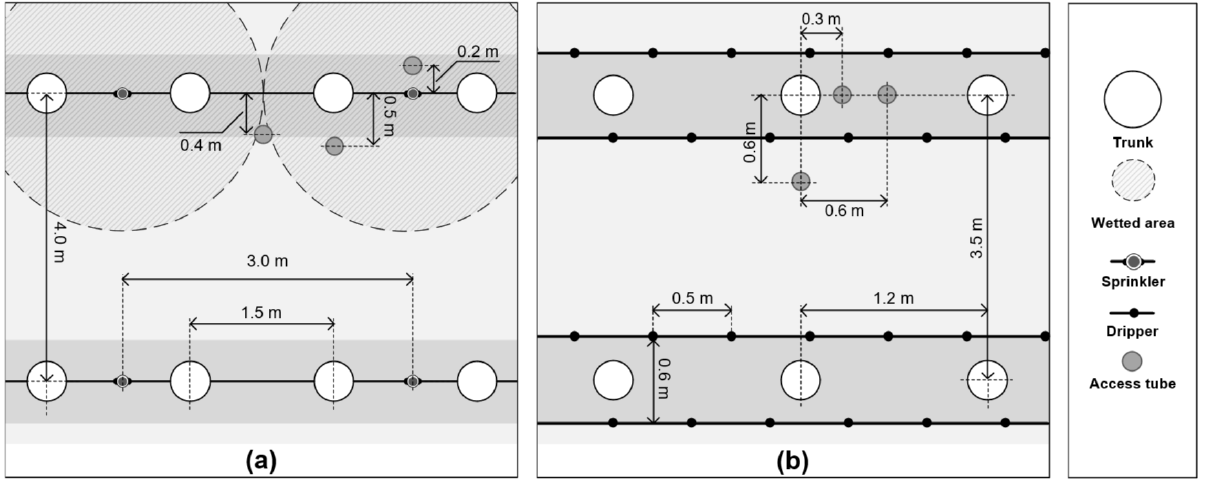
Figure 2. Irrigation scheme and locations of neutron probe access tubes in ( a ) ‘Royal Gala’ and ( b ) ‘Brookfield Gala’ apple orchards.